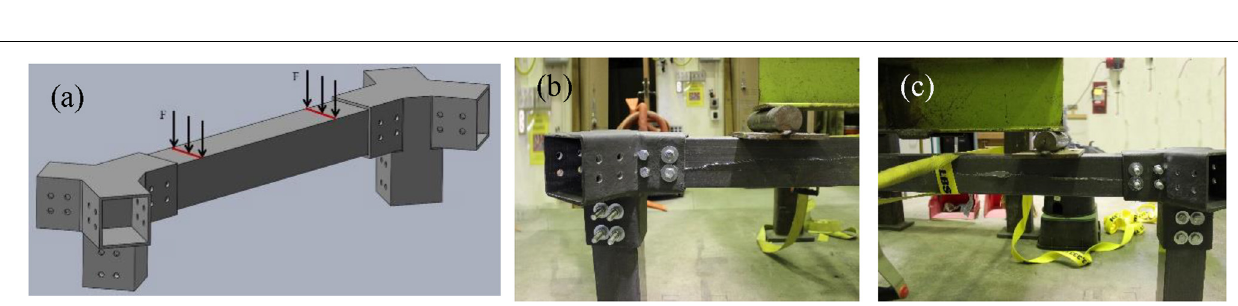
Frontiers in Marine Science |